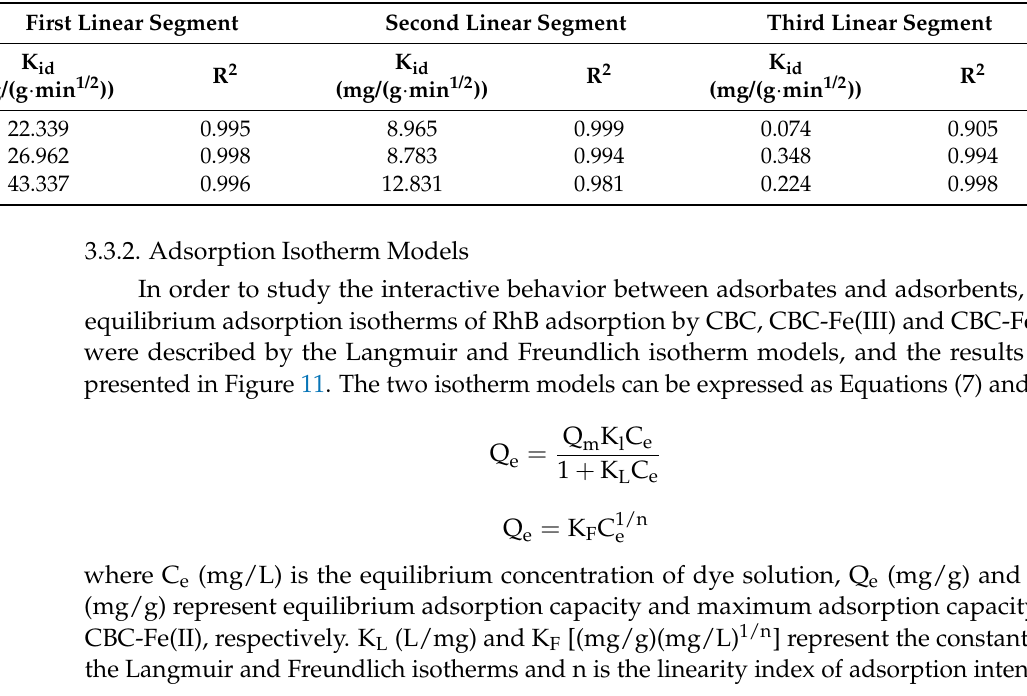
Table 3. Intra ‐ particle diffusion model parameters for RhB adsorption by CBC, CBC ‐ Fe(III) and Table 3. Intra-particle diffusion model parameters for RhB adsorption by CBC, CBC-Fe(III) and CBC ‐ Fe(II). CBC-Fe(II).